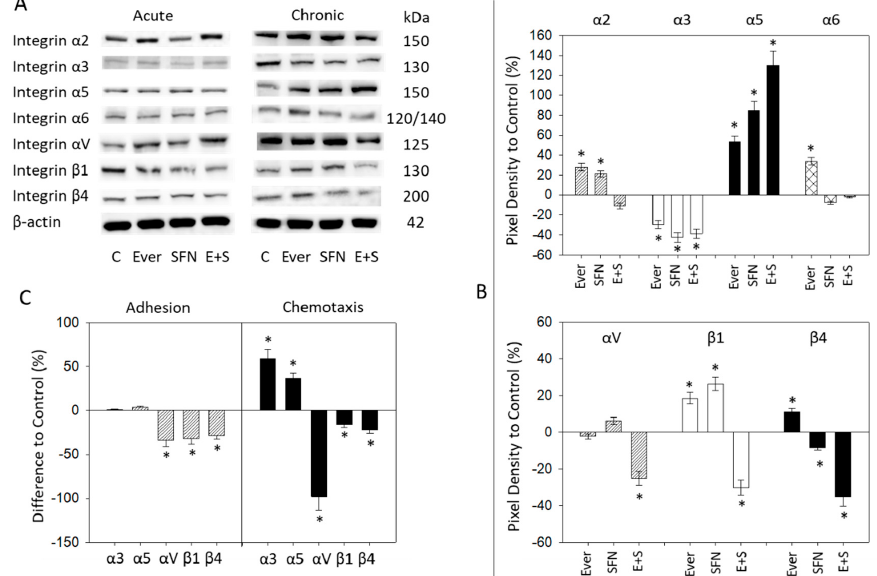
Figure 6 . ( A ) Integrin α and β protein analysis in RT112 cells after acute and chronic exposure